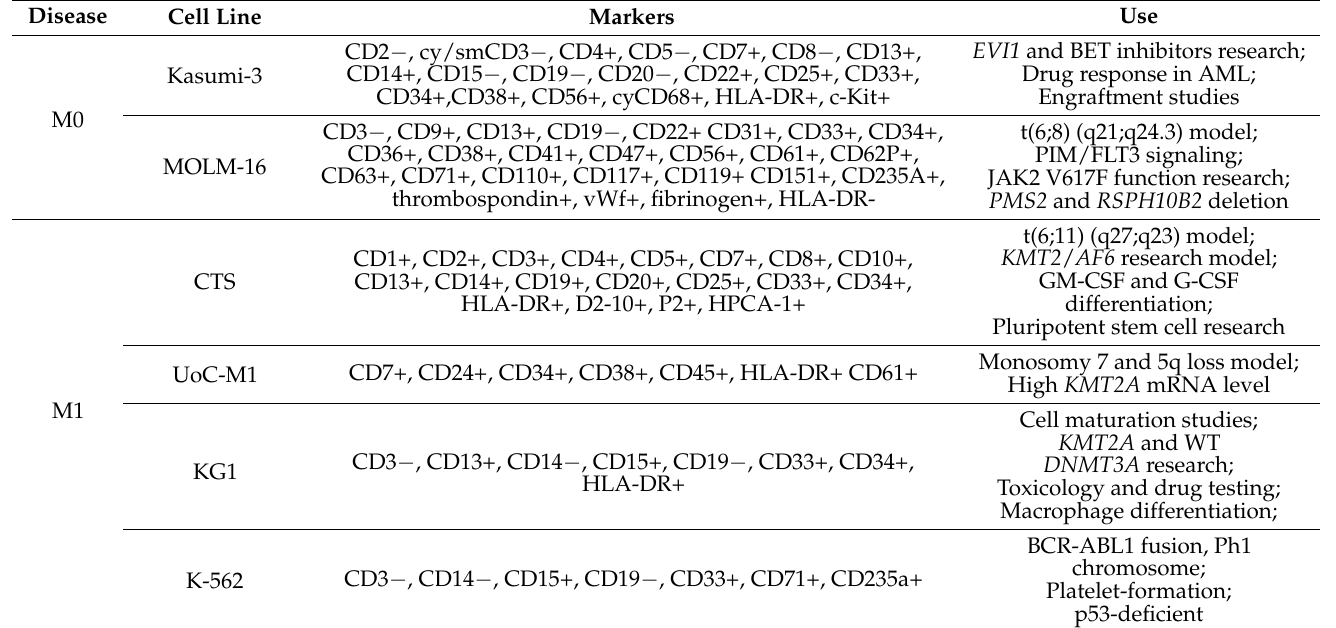
Table 1. Use of AML cell lines with a list of expression markers based on data acquired from DSMZ (German Collection of Microorganisms and Cell Cultures), DSMZ CellDive database, and Cellosaurus database